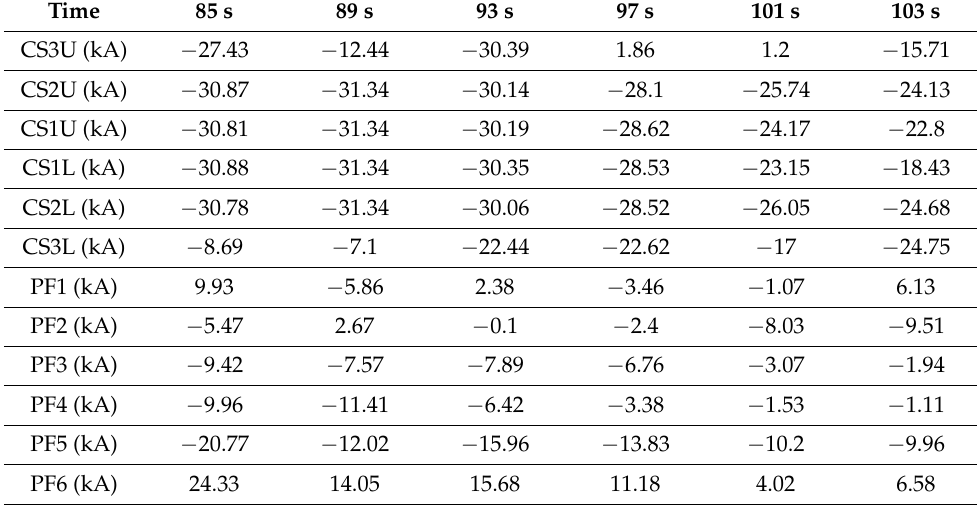
Table 7. Time evolution of CS/PF currents of the SN ramp-down phase at 250 kA/s.